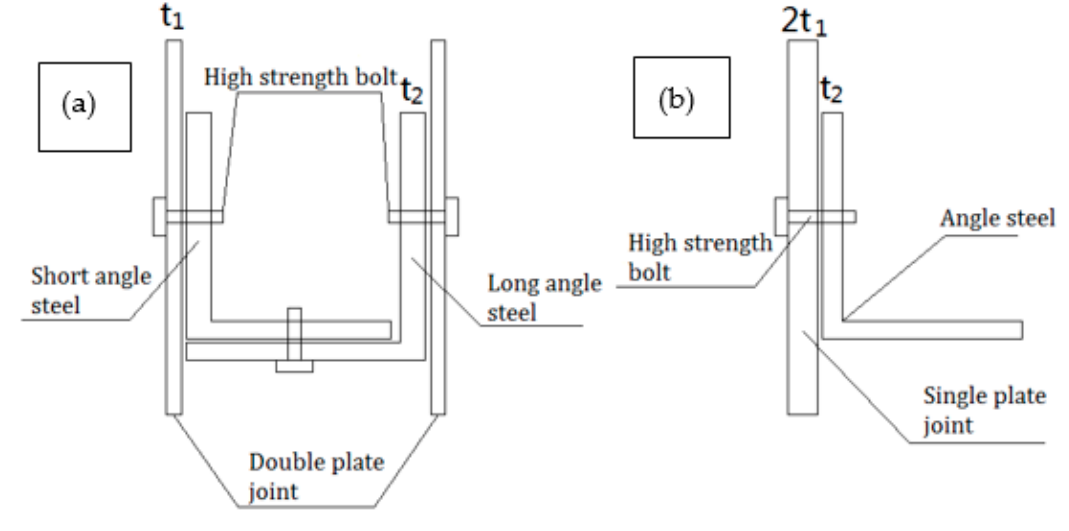
Figure 3. ( a ) Models of PDLDPJ; ( b ) models of PSLSPJ.